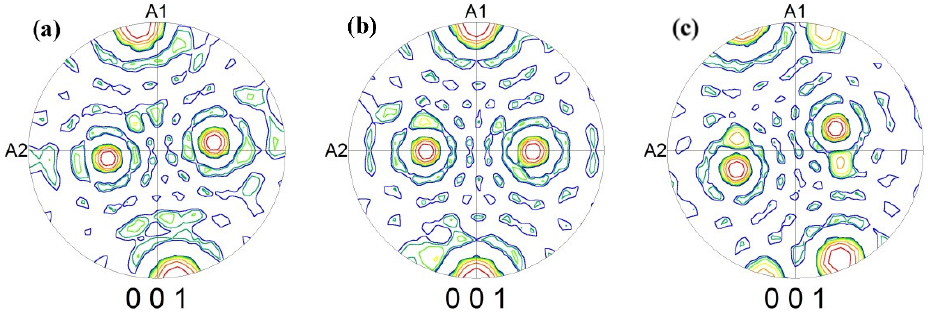
Figure 7. {001} pole figures of finally annealed samples in different atmospheres: ( a ) 100%H 2 ; ( b ) 25%H 2 + 75%N 2 ; ( c ) 50%N 2 + 50%H 2 . ( b ) 25%H 2 + 75%N 2 ; ( c ) 50%N 2 + 50%H 2